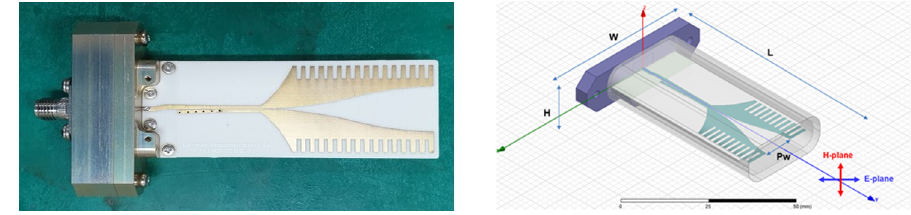
Figure 6. Fabricated Antenna.